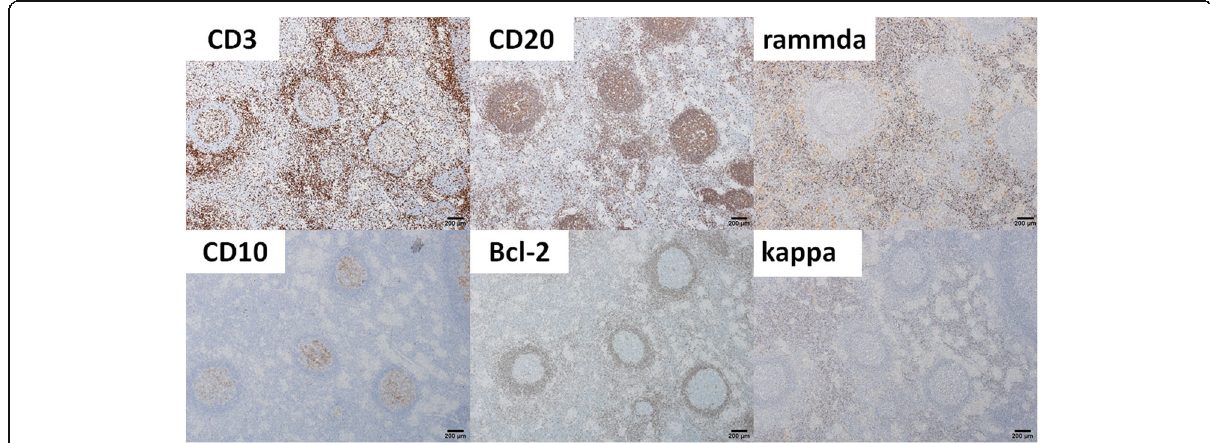
Fig. 5 Immunohistochemical staining reveals that the follicles are CD20-positive. The lymphocytes in the germinal centers are CD10-positive and Bcl-2-negative. The interfollicular area is composed of CD3-positive small T cells. Infiltrating plasma cells show a polyclonal expression of cellular immunoglobulin kappa and lambda